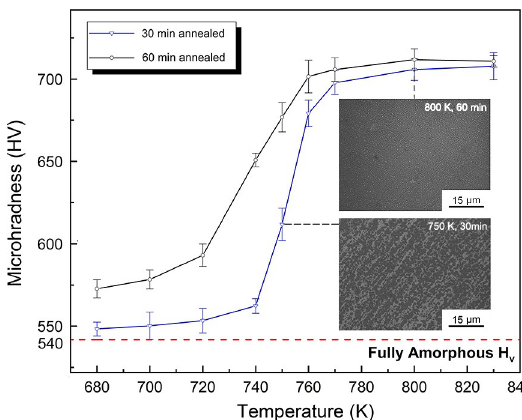
Figure 5. TEM images and corresponding SAED patterns and FFT of (Cu (c, d) 680 K for 30 min; (e, f) 700 K for 30 min.